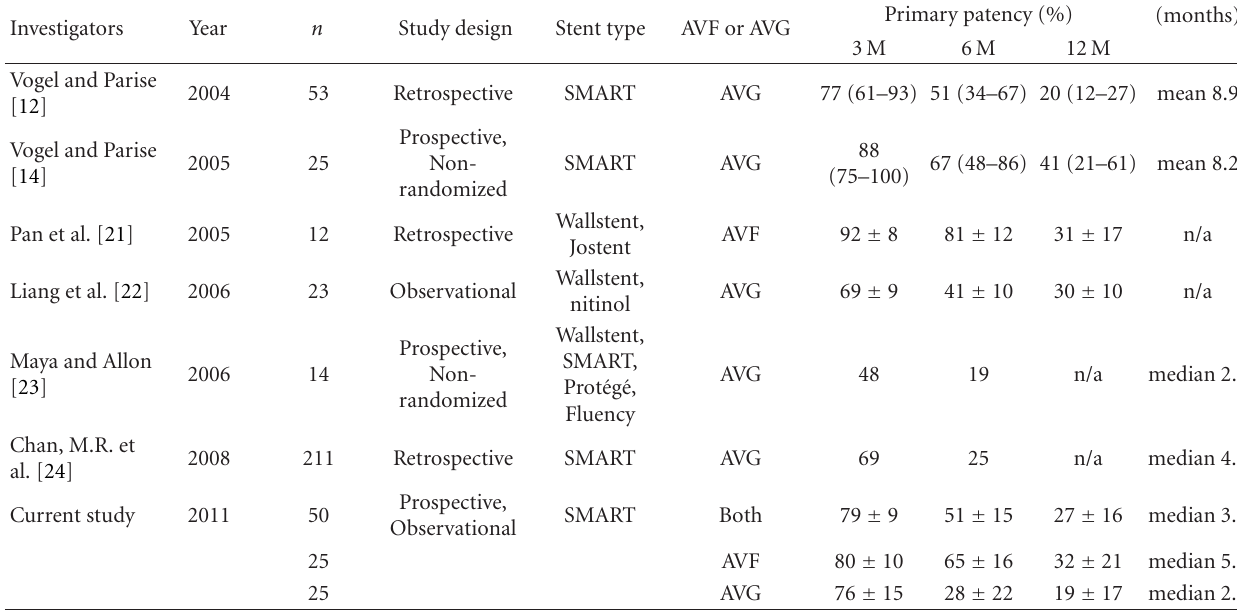
Table 4: Summary of recent reports of outcome using metallic stents. The 3-, 6-, and 12-month patency rates were 77–88%, 51–67%, and 20–41%,